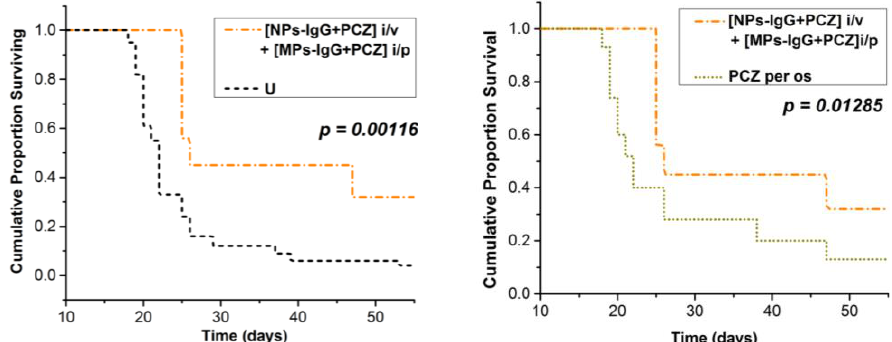
Figure 6. Log-rank Mantel–Cox survival curves comparison: ( A ) [NPs-IgG + PCZ] i.v. + [MPs-IgG + PCZ] i.p. group versus U group; ( B ) [NPs-IgG + PCZ] i.v. + [MPs-IgG + PCZ] i.p. group versus PCZ per os group (see Table 1 for group descriptions).